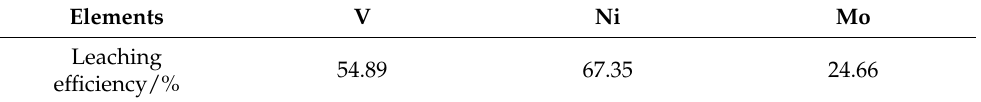
Table 10. Experimental conditions and results of fluorination leaching in the stone coal raw